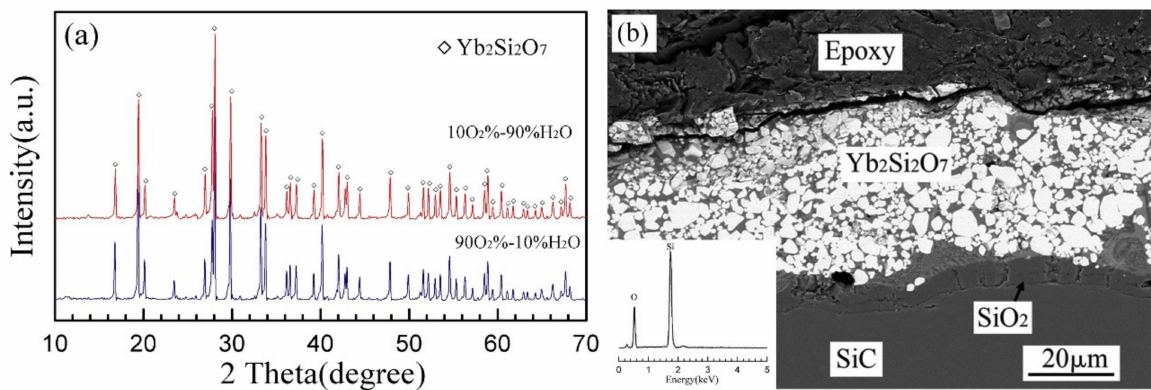
Figure 12. X -ray diffraction (XRD) patterns and typical SEM cross-section morphologies of Yb 2 Si 2 O 7 coated on C/SiC after water-vapor corrosion at 1250 ◦ C under 90 vol.% O 2 –10 vol.% H 2 O and 10 vol.% O 2 – 90 vol.% H 2 O: ( a ) XRD patterns after corrosion for 200 h, and ( b ) SEM cross-section after corrosion for 100 h under 10 vol.% O 2 –90 vol.% H 2 O